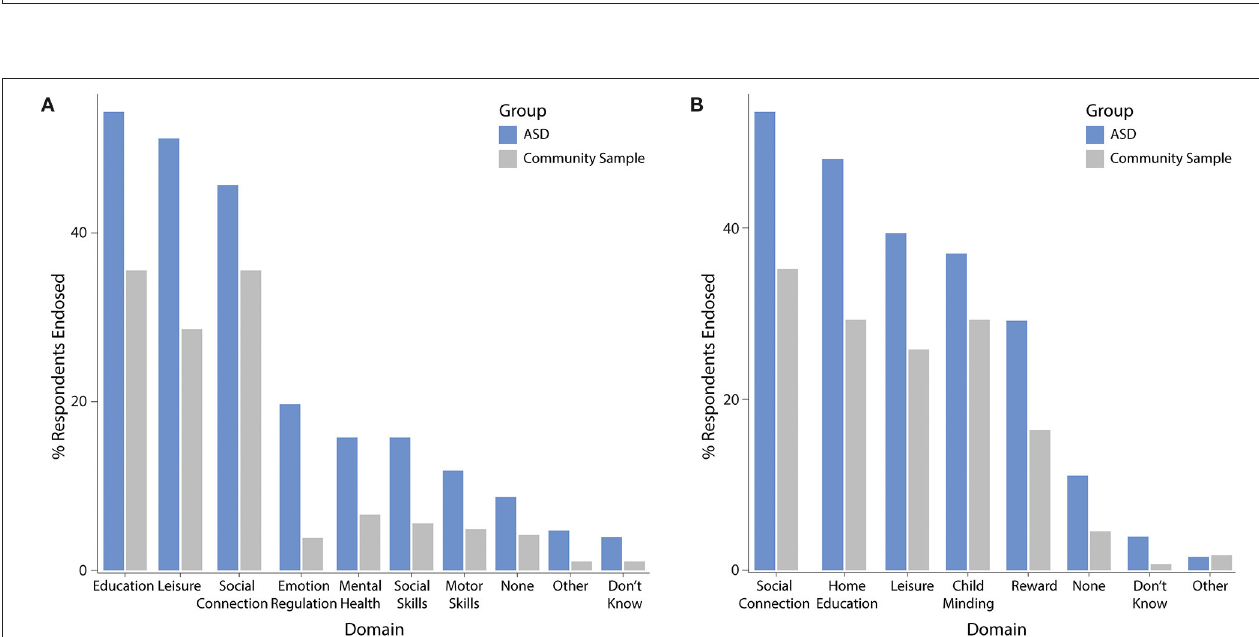
FIGURE 6 | Perceived screen time benefits for (A) the child and (B) the